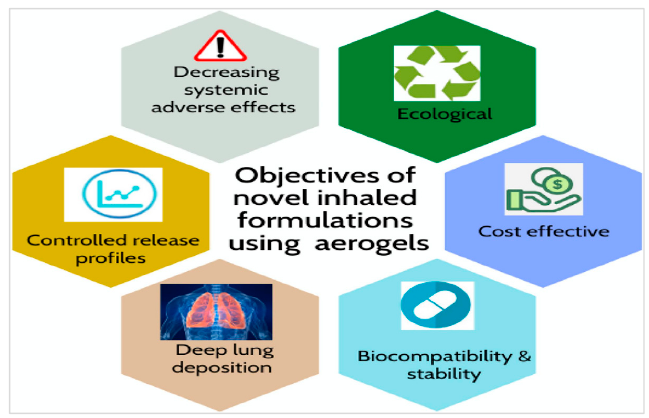
Figure 9. Possible advantages of aerogel-based carriers for the administration of pulmonary drugs [195].